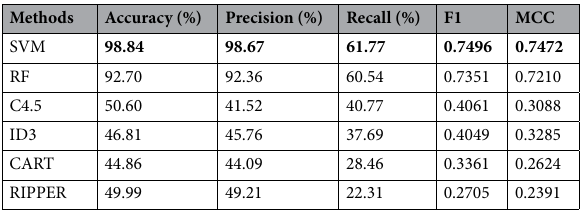
Table 4. Average results of fivefold CV for positive class. Significant values are in bold.